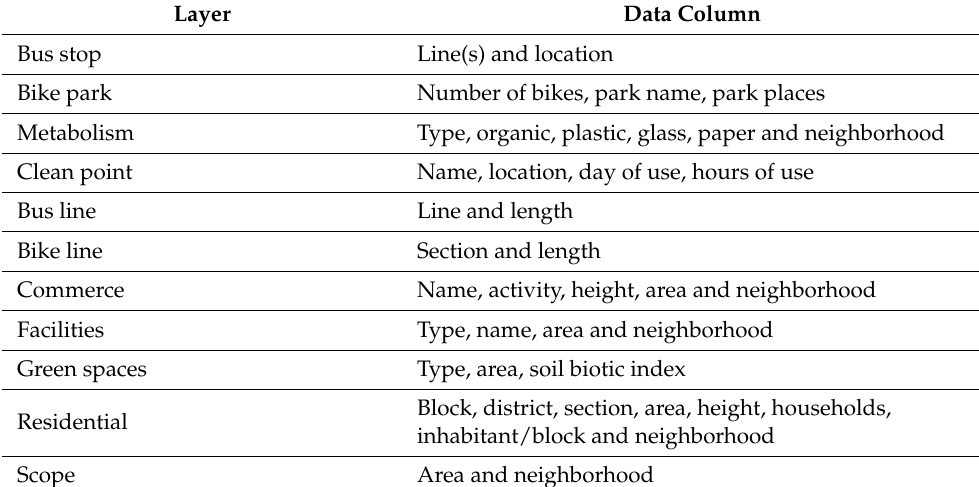
Table 1. Data column of each of the neighborhoods in